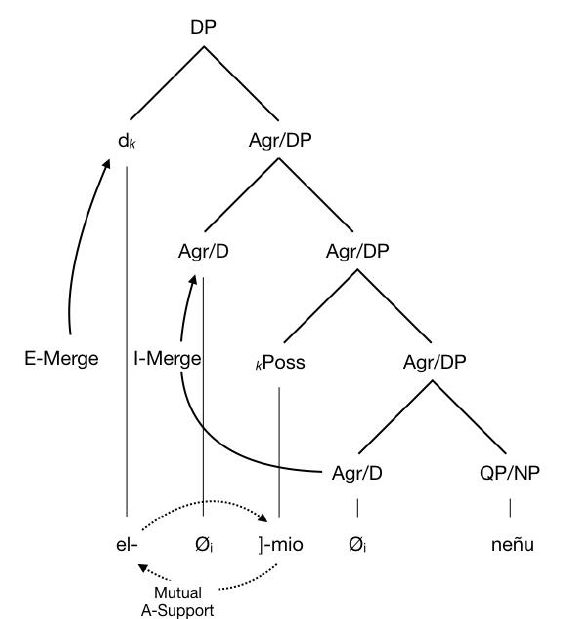
Figure 3. Prenominal possessive construction (Type I: e.g. el mio neñu